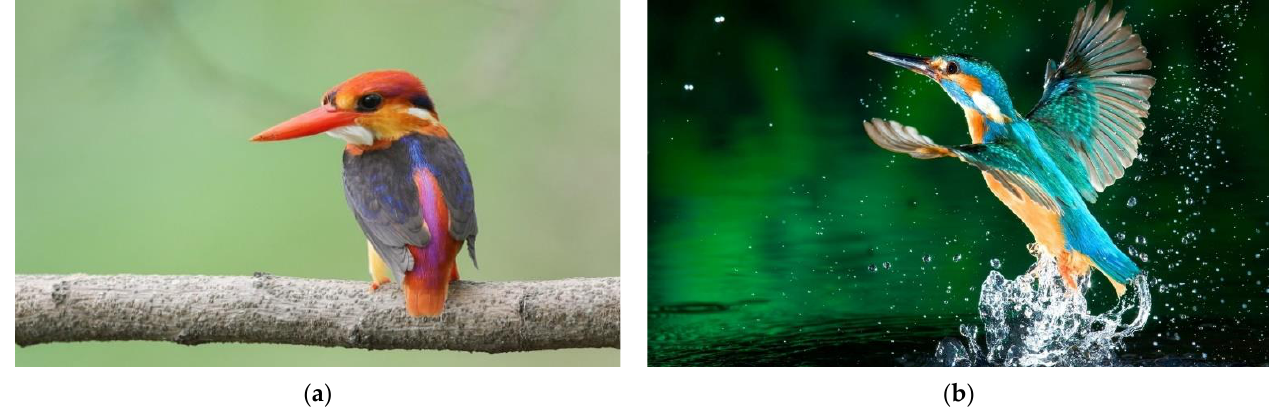
Figure 1. ( a ) Oriental Dwarf Kingfisher ( Ceyx erithacus ) [19]; ( b ) typical flying sequence of the kingfisher after hunting. Look at the downstroke with full wing spread (alula’s) to generate lift (Image free from www.wallpaperflare.com) (accessed on 14 April 2022).